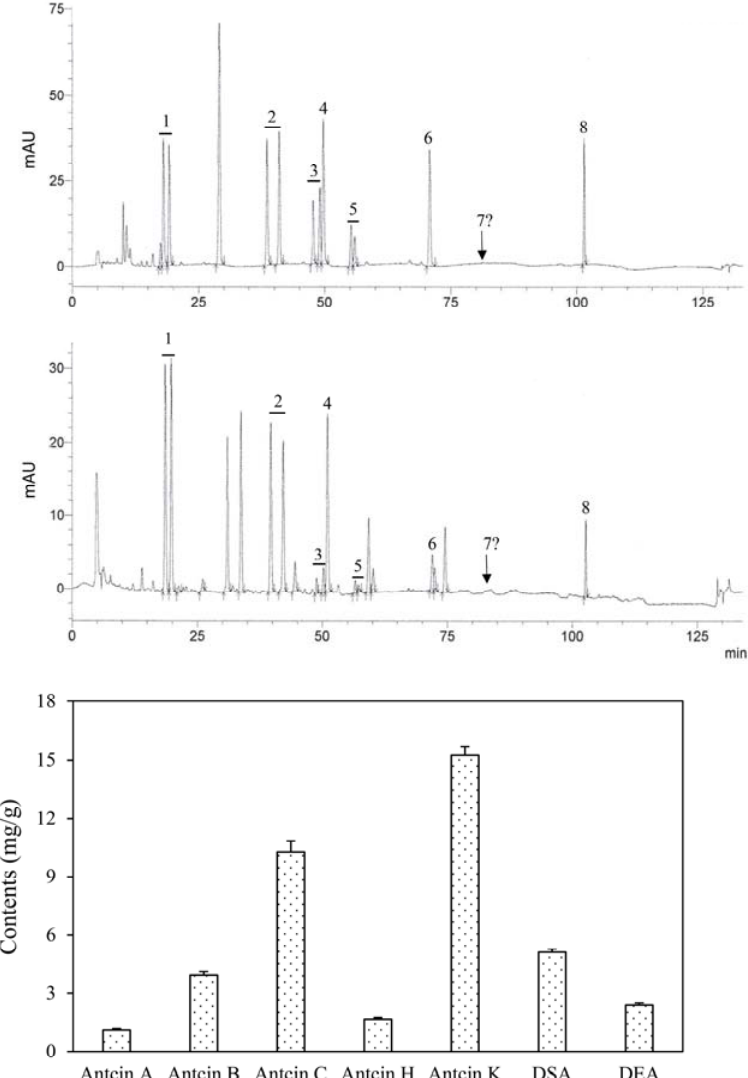
Figure 2. Representative chromatograms and contents of bioactive triterpenoid compounds in the powders of disc ‐ cultured Antrodia cinnamomea fruiting bodies. Peaks 1 = antcin K; 2 = antcin C, 3 = antcin H, 4 = dehydrosulphurenic acid (DSA), 5 = antcin B, 6 = antcin A, 7 = 15 ‐ acetyldehydrosul ‐ phurenic acid; 8 = dehydroeburicoic acid (DEA). The underlined numbers indicate compounds that are present in both R ‐ form and S ‐ form, and were treated and calculated as the same compound.